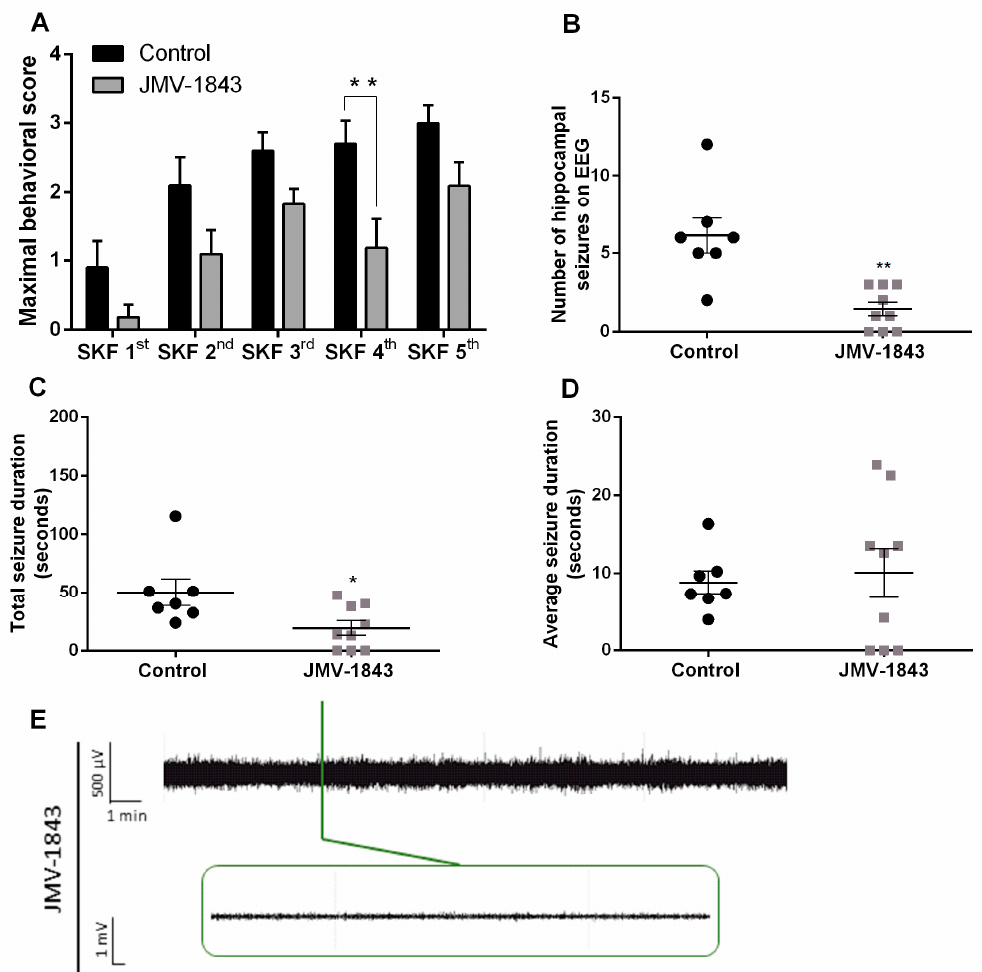
Figure 2. JMV-1843 attenuates seizures in the D1R-mediated kindling model. ( A ) Maximal behavioral score was lower in JMV-1843 treated mice ( n = 11) compared to saline-treated controls ( n = 10). Two-way RM ANOVA (Interaction p > 0.05, F(4,76) = 0.5059; Time p < 0.0001, F(4,76) = 11.87; Treatment p < 0.001, F(1,19) = 18.85). ( B ) The number of hippocampal seizures on EEG recordings was lower in JMV-1843 ( n = 9) treated mice compared to saline-treated controls ( n = 7). Mann–Whitney test ( p < 0.01; Mann–Whitney U = 3.500). ( C ) Total seizure duration was lower in JMV-1843 treated mice ( n = 9) compared to controls ( n = 7). Mann–Whitney test ( p < 0.05; Mann–Whitney U = 11.00). ( D ) Average seizure duration did not differ between JMV-1843 treated mice ( n = 9) and controls ( n = 7). Mann–Whitney test ( p > 0.05; Mann–Whitney U = 30.00). ( E ) Representative trace of JMV-1843-treated mouse during SKF 5th. 0.3 Hz high-pass, 60 Hz low-pass, and 50 Hz power line filters were applied. Data are presented as mean ± SEM. * p < 0.05; ** p < 0.01. EEG, electro-encephalography; µV, microvolt; mV, millivolt; min, minute; s, second; SKF, SKF81297.